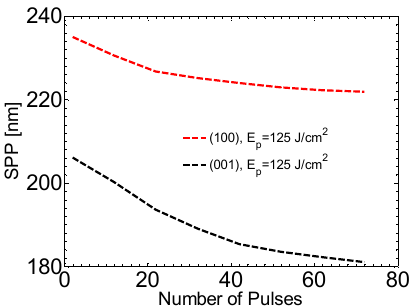
Figure 9. SPP wavelength vs NP . ( t delay = 4 ps, E p = 125 mJ/cm 2 for (100) and (001) TiO 2 ).